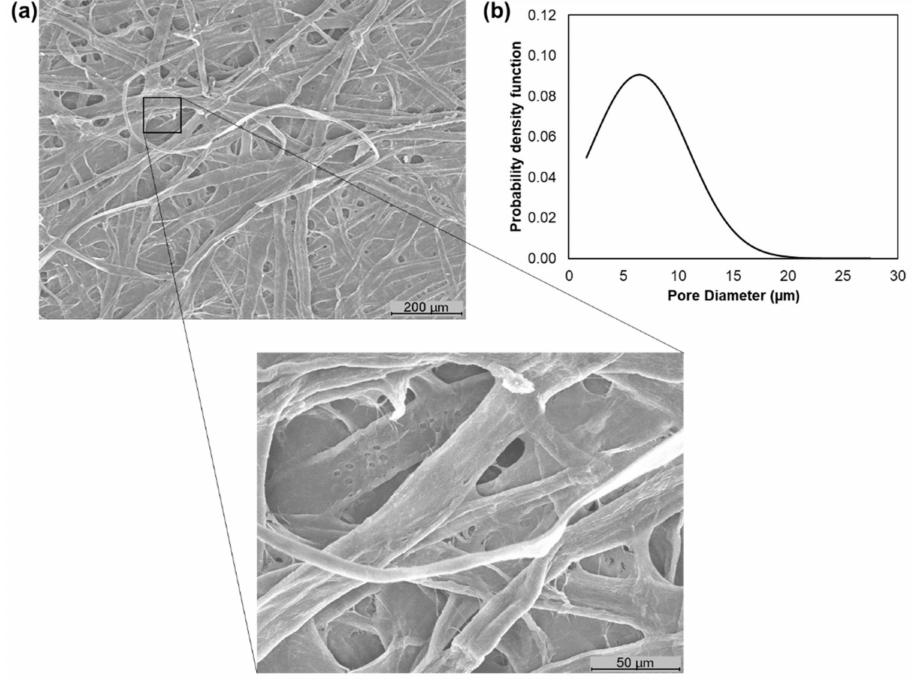
Figure 3. SEM image of the softwood pulp with refining and enzymatic treatment with a high magnification image (500 × ) ( a ) and its pore diameter distribution ( b